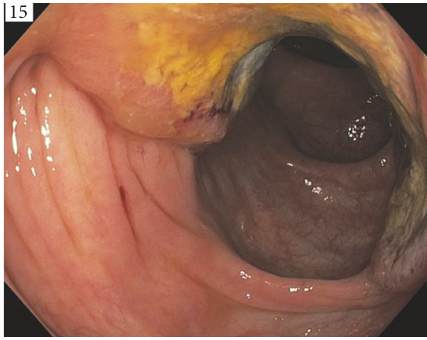
Figure 2: A large, friable, and infiltrative tumor which occupied 50 to 74% of the circumference of the ascending colon.